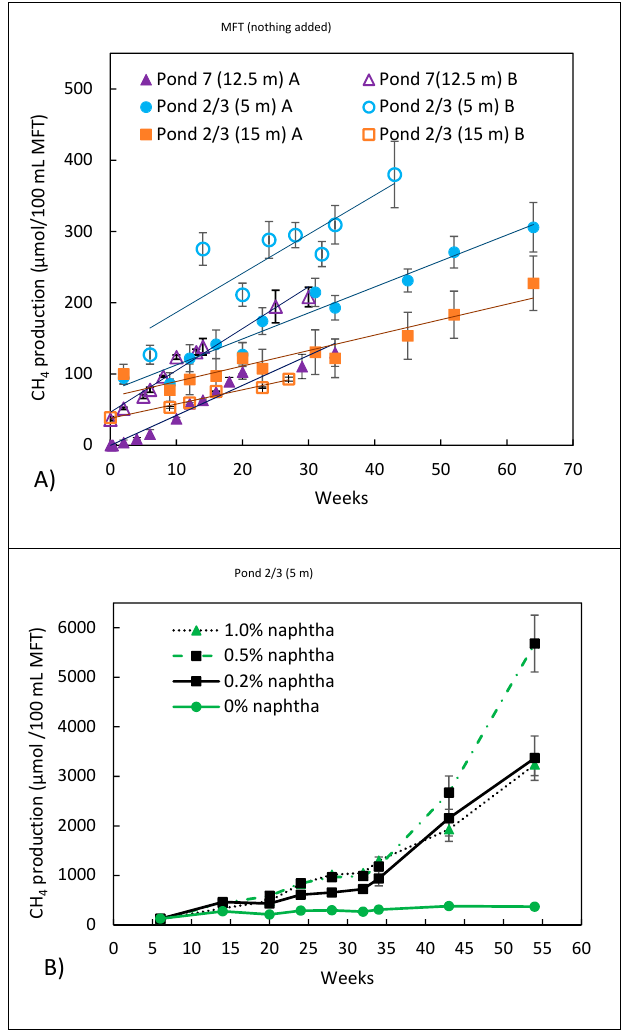
Figure 1. ( A ) Methane production of duplicate microcosms for each MFT sample in two independent experiments, each performed in duplicate. No amendments were added. The solid line represents the average rate of methane production for each pond sample as baseline conditions. ( B ) Methane production from duplicate MFT samples from Pond 2/3 at 5 m when naphtha alone was added. After naphtha addition, microcosms were mixed for 30–60 min on a rotary shaker then incubated in the dark. Error bars have been inserted, and where not visible, the error was too small to be